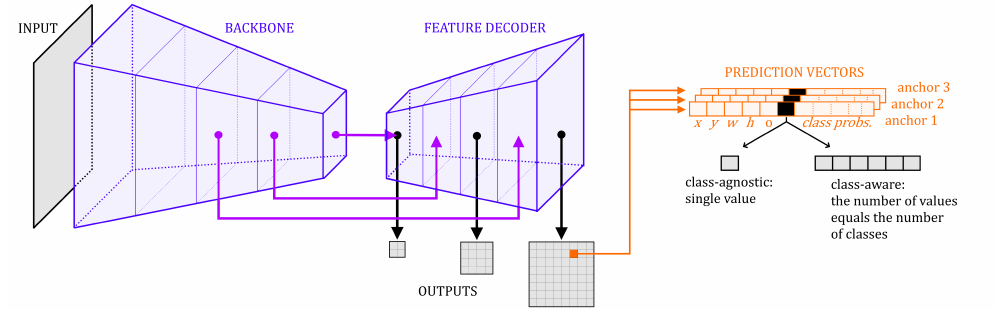
Figure 1. The figure illustrates how the YOLO architecture is modified to estimate the distance of objects. The part enriching YOLO by distance estimation is visualized by the black box in the prediction vector (marked by orange